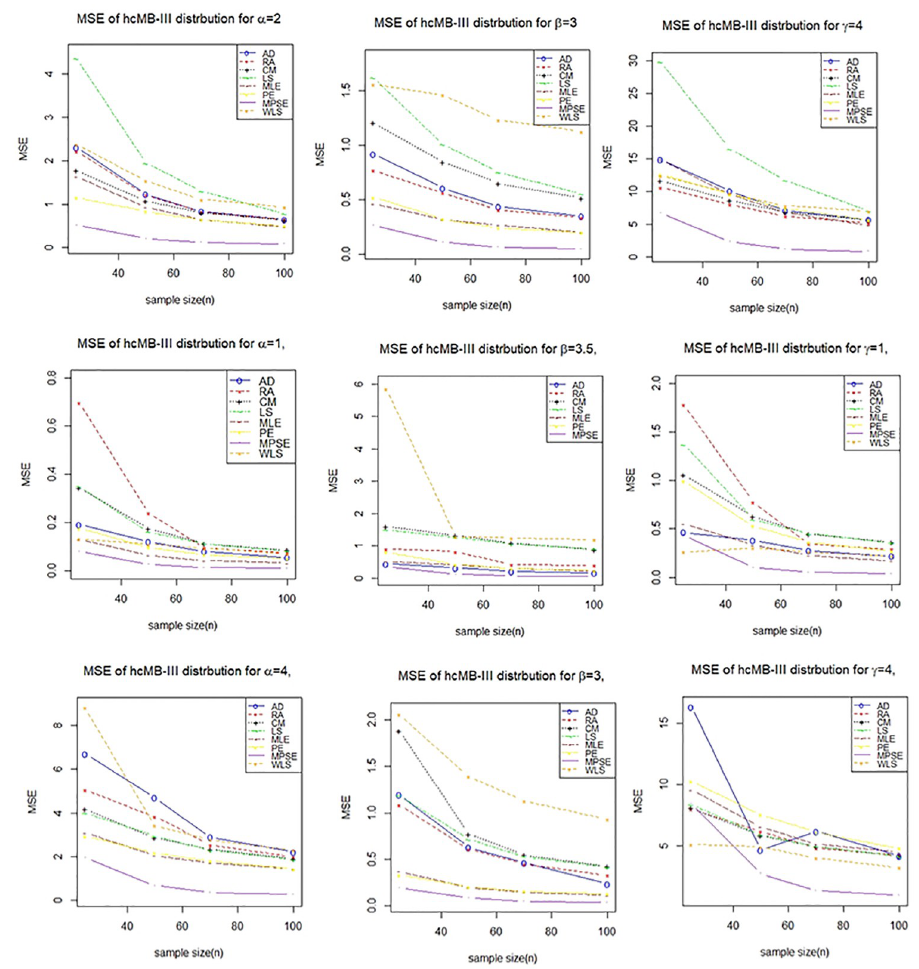
Fig 5. MSE for different sample sizes and estimation methods for different parameters values of ( α , β , γ ).